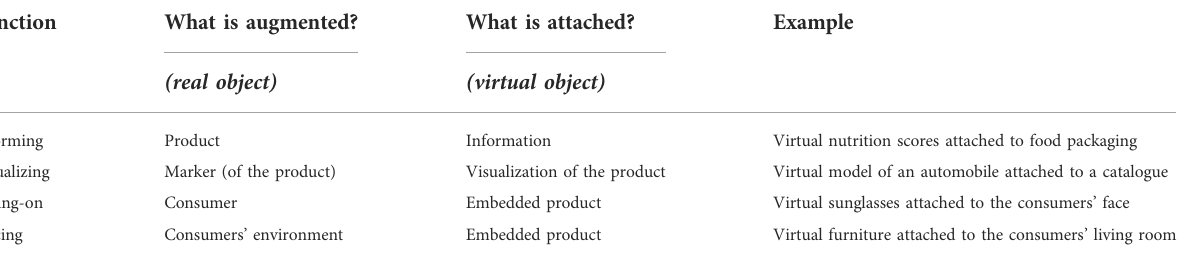
TABLE 1 Applications of AR in